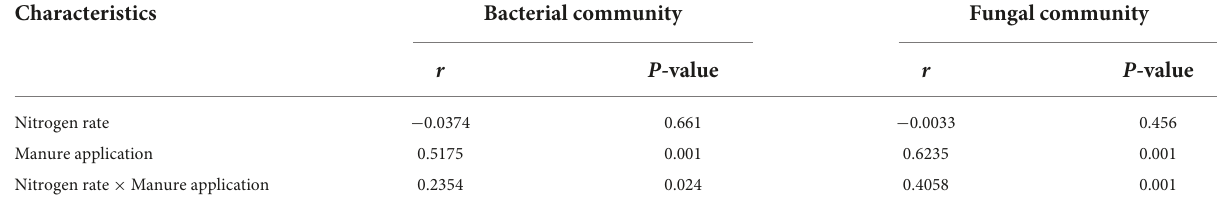
TABLE 2 Similarity analysis (ANOSIM) of soil microbial communities under different nitrogen and manure treatments. Characteristics Bacterial community Fungal community r P -value r P -value Nitrogen rate − 0.0374 0.661 Manure application 0.5175